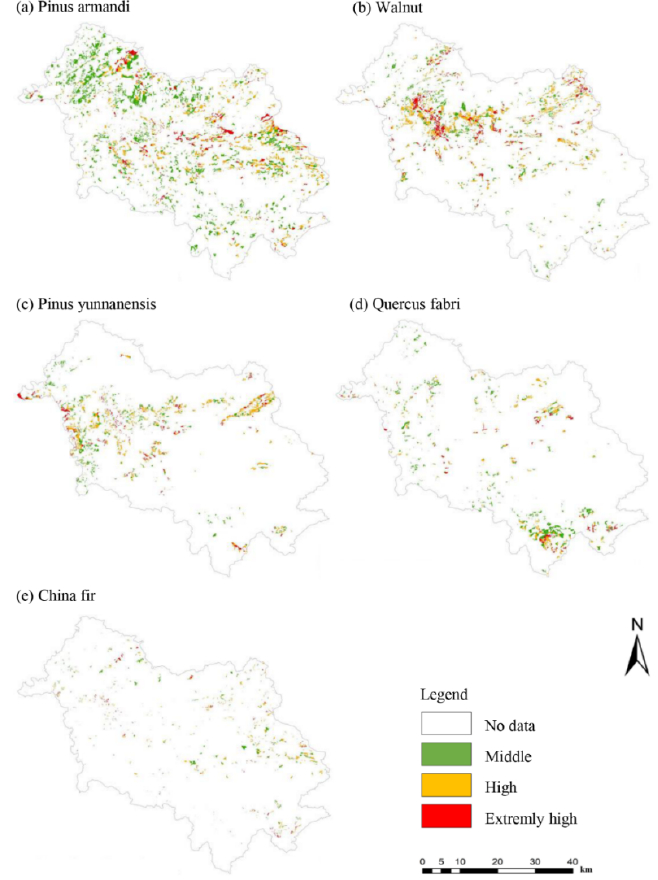
Figure 13. Spatial distribution map of landslide susceptibility of dominant tree species in Hezhang County.